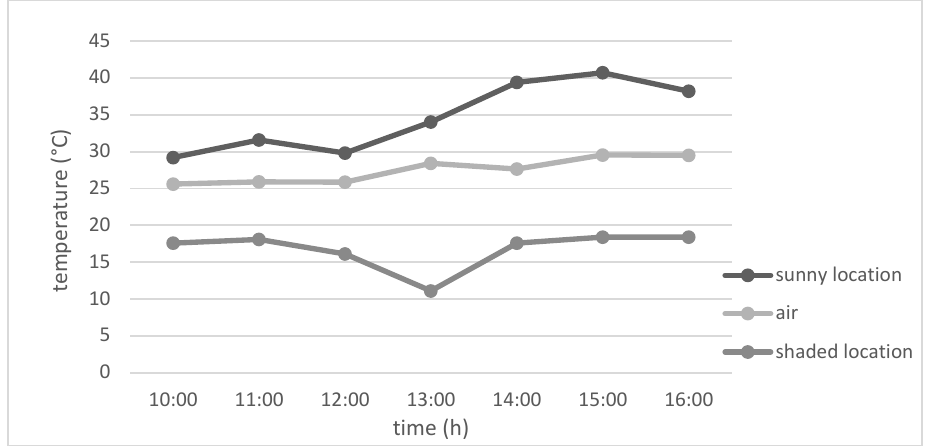
Figure 8. Development of temperatures in a sunny/shaded place during the day on the surface of a gravel abrasive layer of crushed aggregate 8/16 mm, which is operationally strengthened, 18th August 2019.